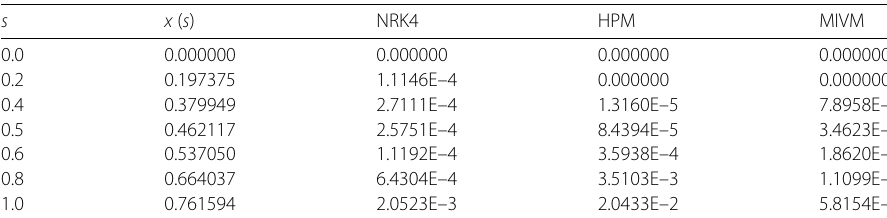
Table 2 Relative errors for Example 1, α = 1